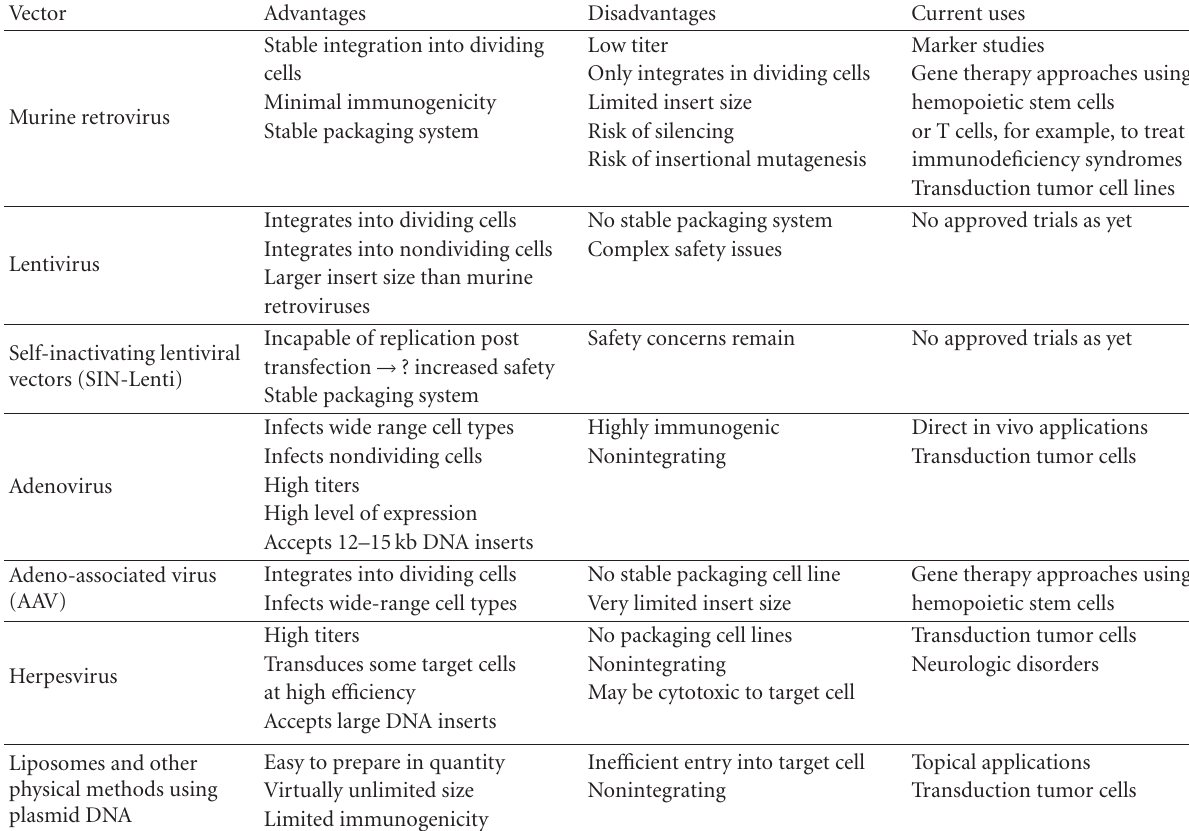
Table 1. Advantages and disadvantages of vector